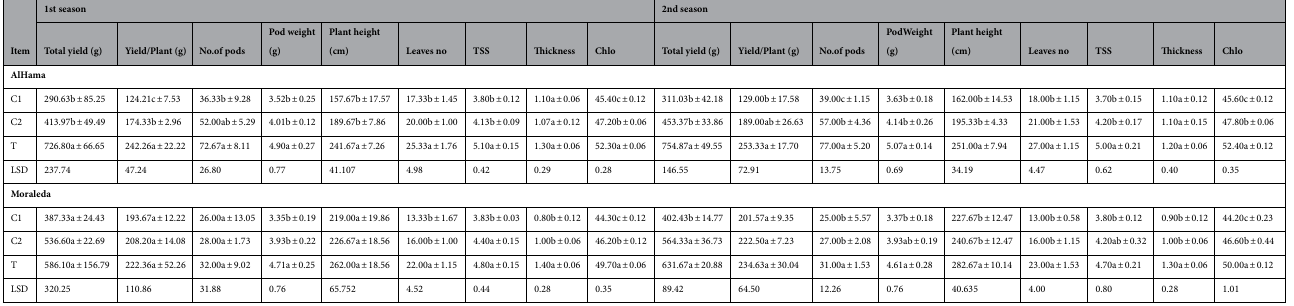
Table 1. Effect of the application of BSTC on the growth parameters of P. vulgaris , AlHama and Moraleda cvs, during 2019 and 2020 cultivating seasons. Averages with different letters have a significant difference at the